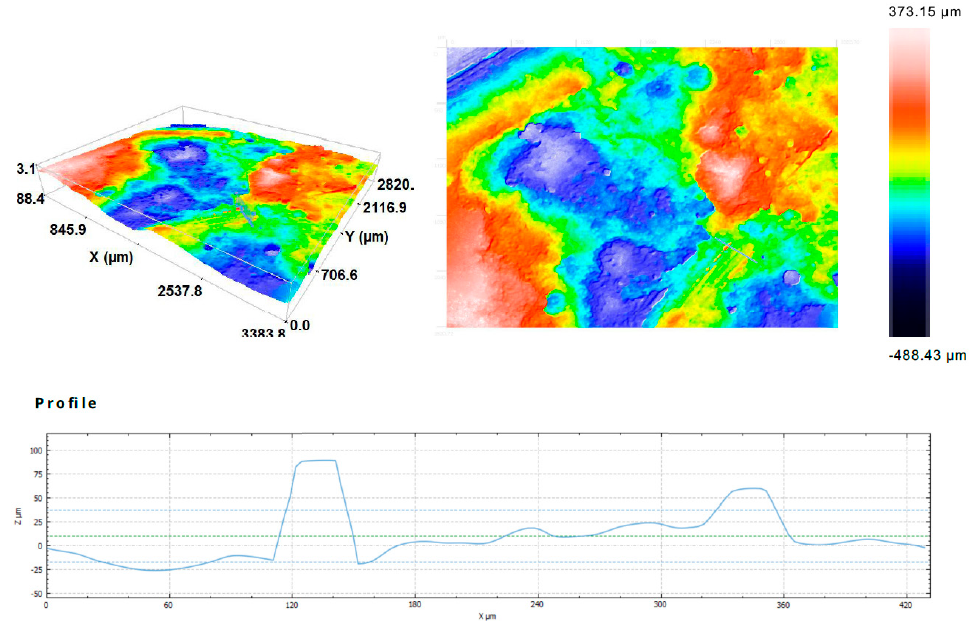
Figure 8. 3D confocal microscopy images and profile curve of the carbon fiber reinforced composite made by simulation of additive